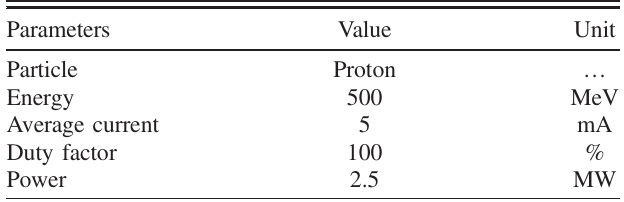
TABLE I. Beam parameters in the linac of